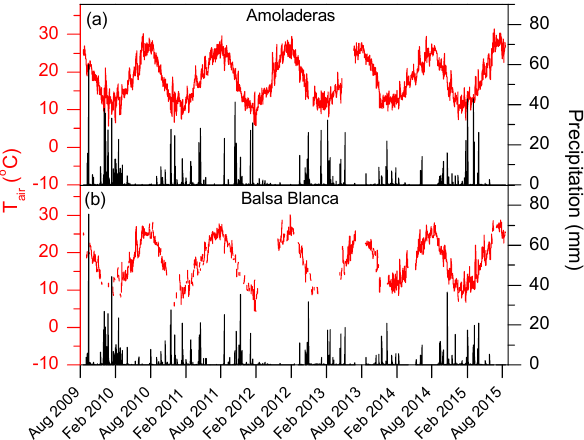
Figure 2. Daily averages of air temperature ( T air ) and precipitation in (a) Amoladeras and (b) Balsa